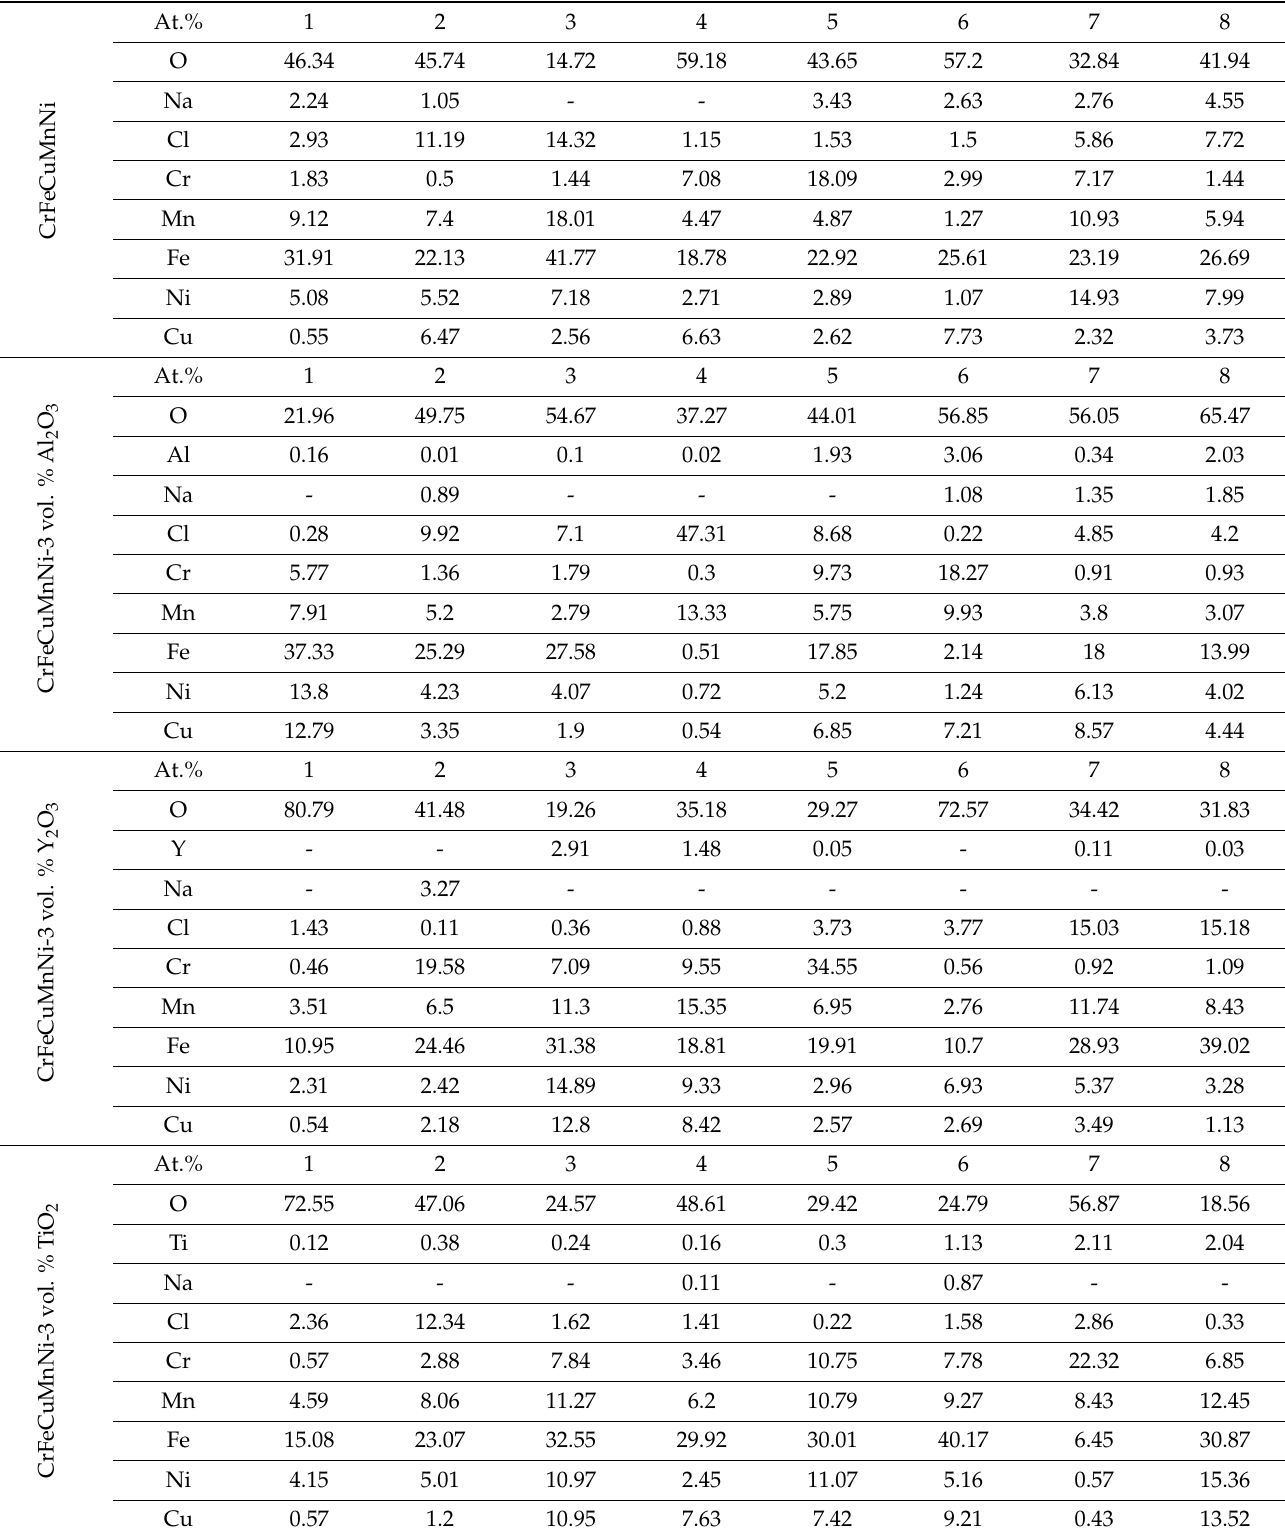
Table 5. EDS point analysis on several regions on corroded samples for the fabricated